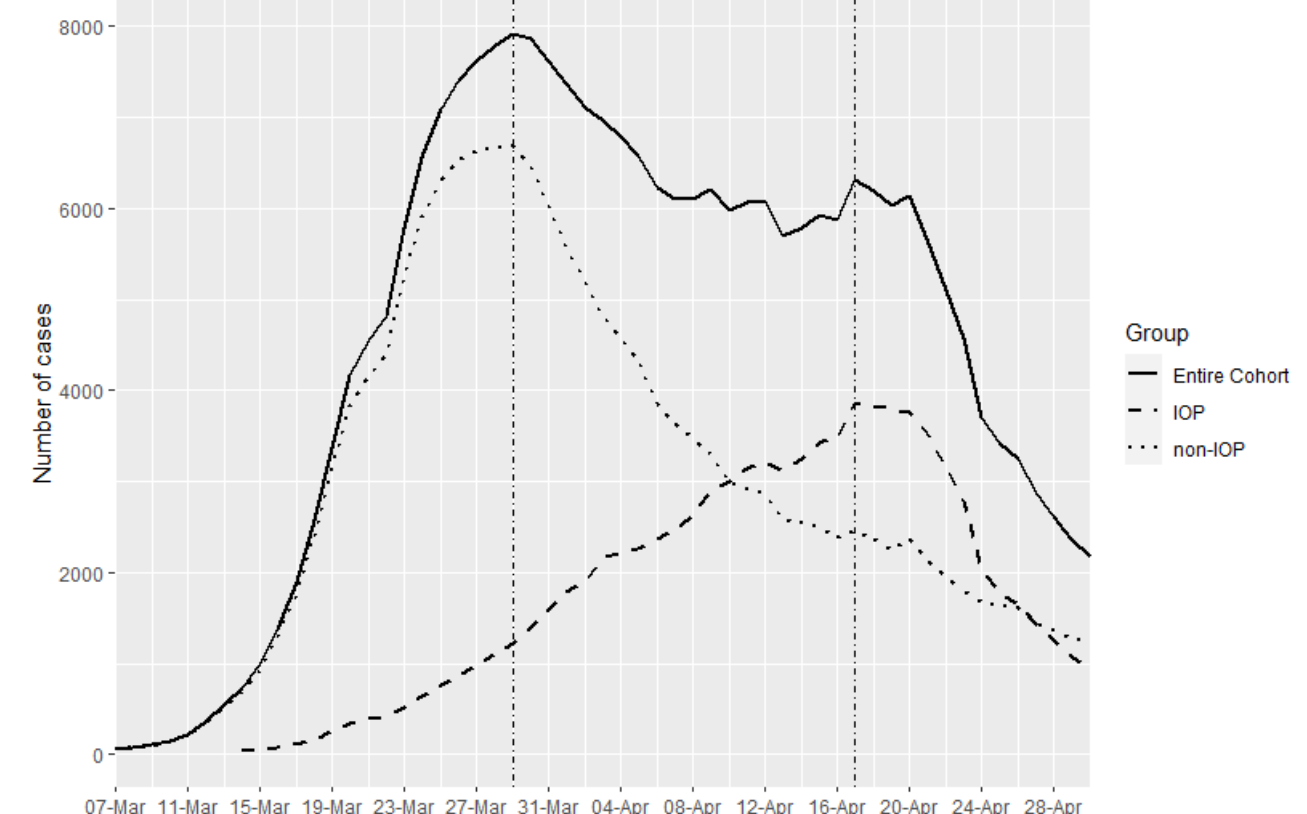
Figure 2. Weekly cumulative incidence curve of COVID-19 cases by place of residence.